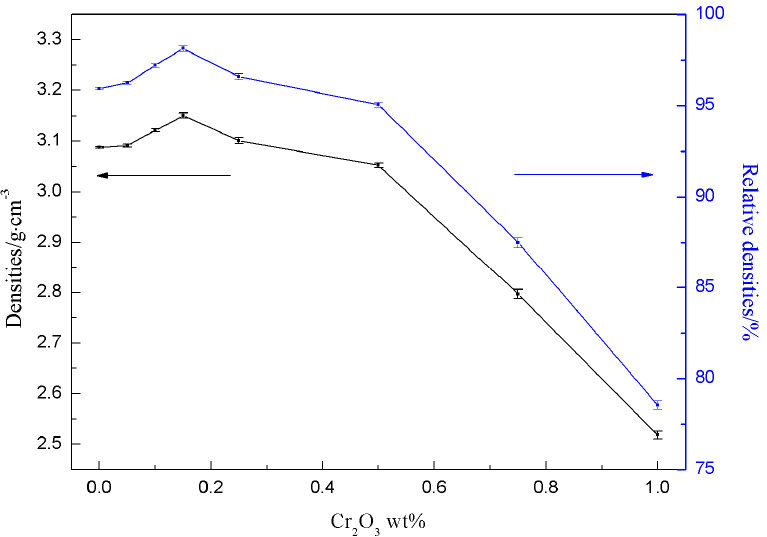
Figure 6. The densities and the relative densities of the sinters for different amounts of Cr 2 O 3 doping.